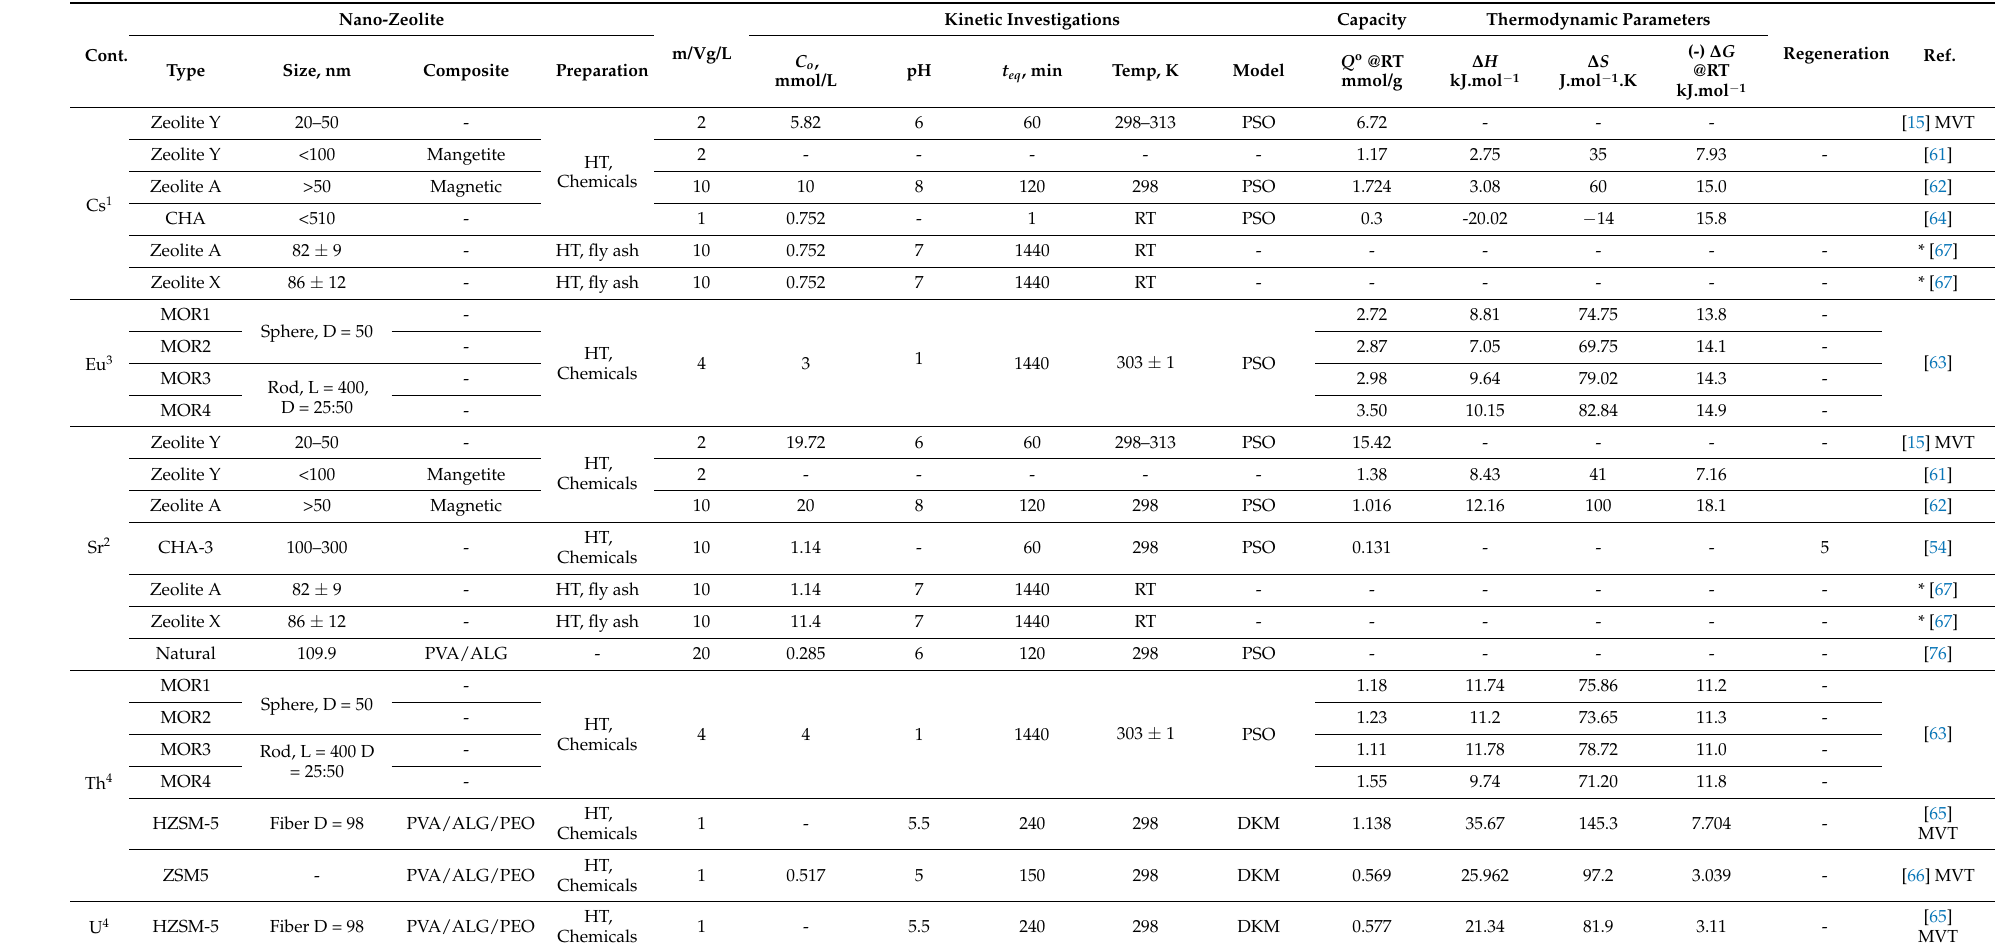
Table 4. Batch investigations of nano-zeolites applications in radioactive contaminant